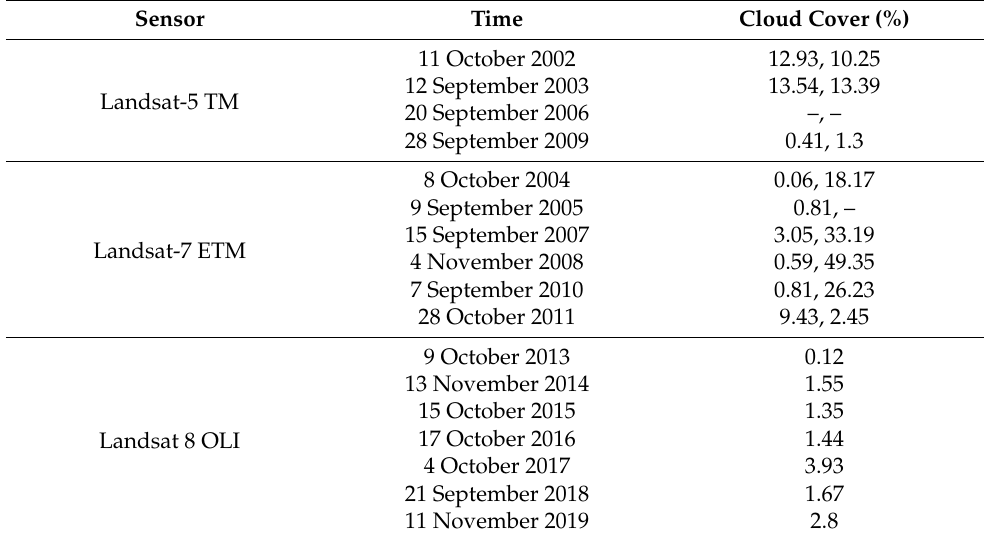
Table 1. Landsat data usage